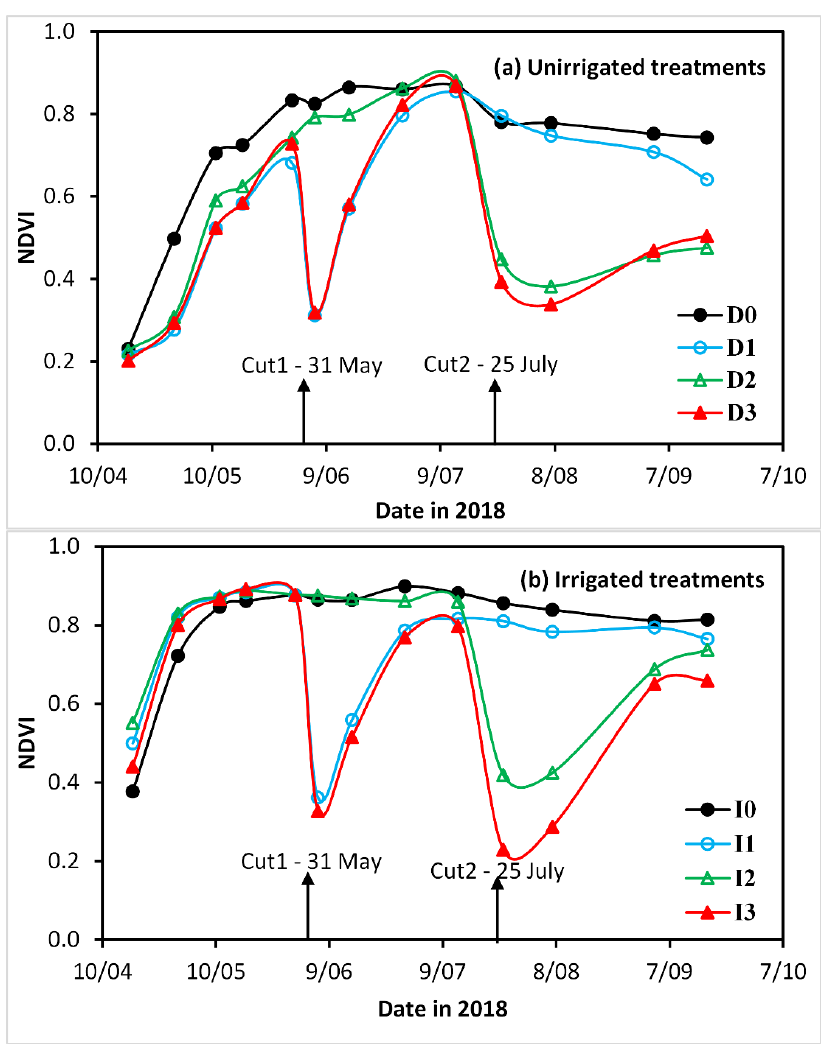
Figure 3. Normalized difference vegetation index (NDVI) used as a proxy for crop canopy cover of a dual-purpose wheat at different times during the crop growing season. The times of grazing are indicated by the arrows. D0 and I0 (ungrazed), D1 and I1 (grazed 31 May), D2 and I2 (grazed 25 July), and D3 and I3 (grazed 31 May and 25 July).